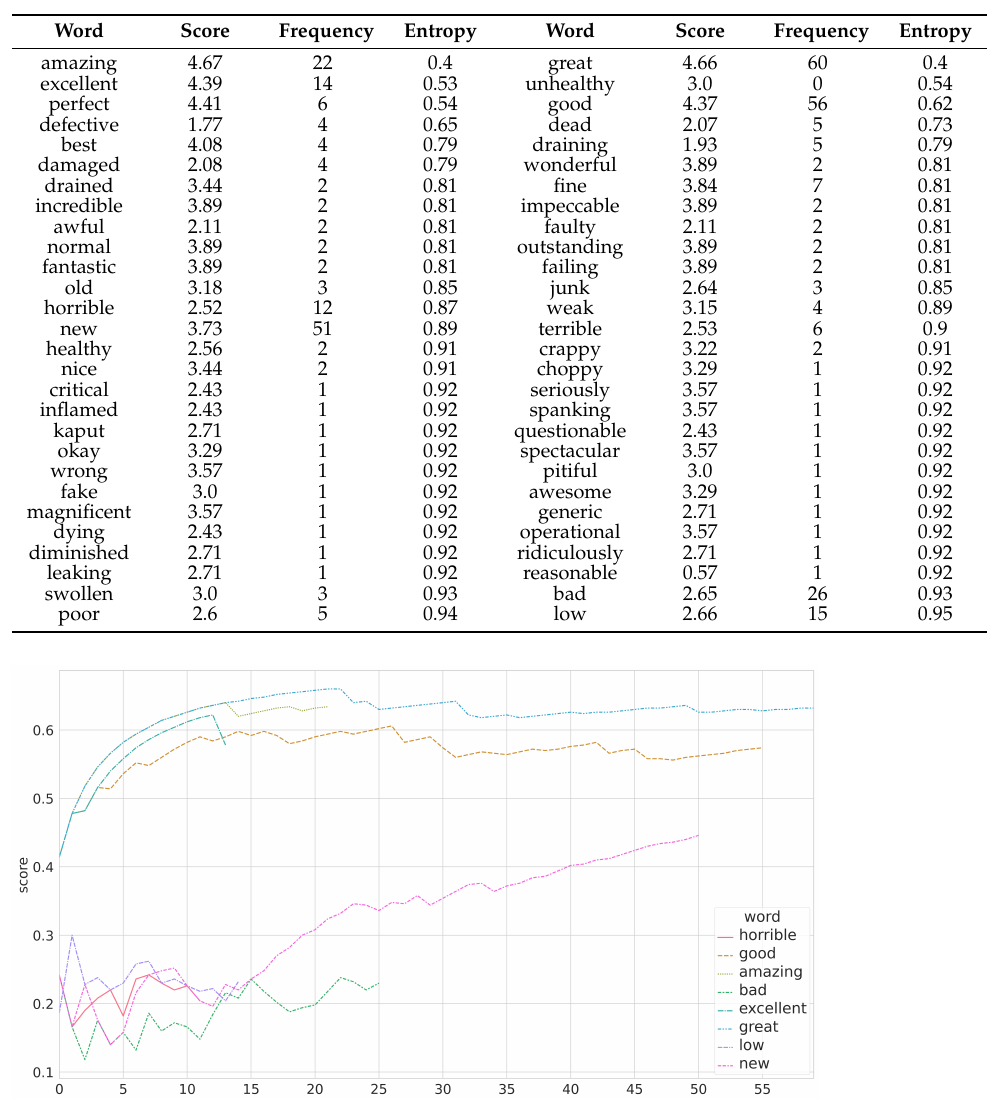
Table 9. Sentiment score of battery-related adjective.